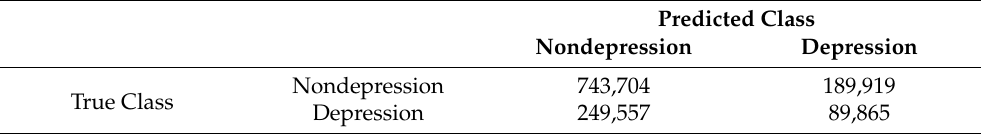
Table 9. An example of the confusion matrix obtained by the binary classification in Setting 2.